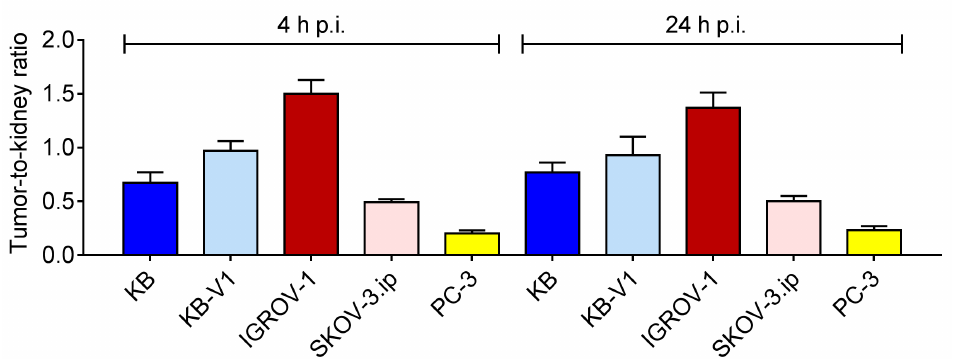
Figure 6. Tumor-to-kidney ratios of accumulated radioactivity in tumor-bearing mice 4 h and 24 h after injection of the radiofolate. The tumor-to-kidney ratios of all groups of mice bearing FR-positive tumor types (KB, KB-V1 or IGROV-1, respectively) were significantly different ( p < 0.05) than the tumor-to-kidney ratio in PC-3 tumor-bearing mice. An exception was the tumor-to-kidney ratio of SKOV-3.ip tumor-bearing mice which was significantly different ( p < 0.05) from the ratios in PC-3 tumor-bearing mice only at 4 h p.i. but not ( p > 0.05) at 24 h p.i. of the radiofolate. In agreement with this analysis, it was found that the absolute tumor uptake 24 h after injection of the radiofolate was highest for IGROV-1 tumor xenografts (~34% IA/g) followed by KB (~22% IA/g), KB-V1 (~17% IA/g) and SKOV-3.ip tumors (~13% IA/g). A clearly reduced accumulation of activity was found in PC-3 tumors (~6% IA/g) at the same time point (Supplementary Materials Tables S1 and